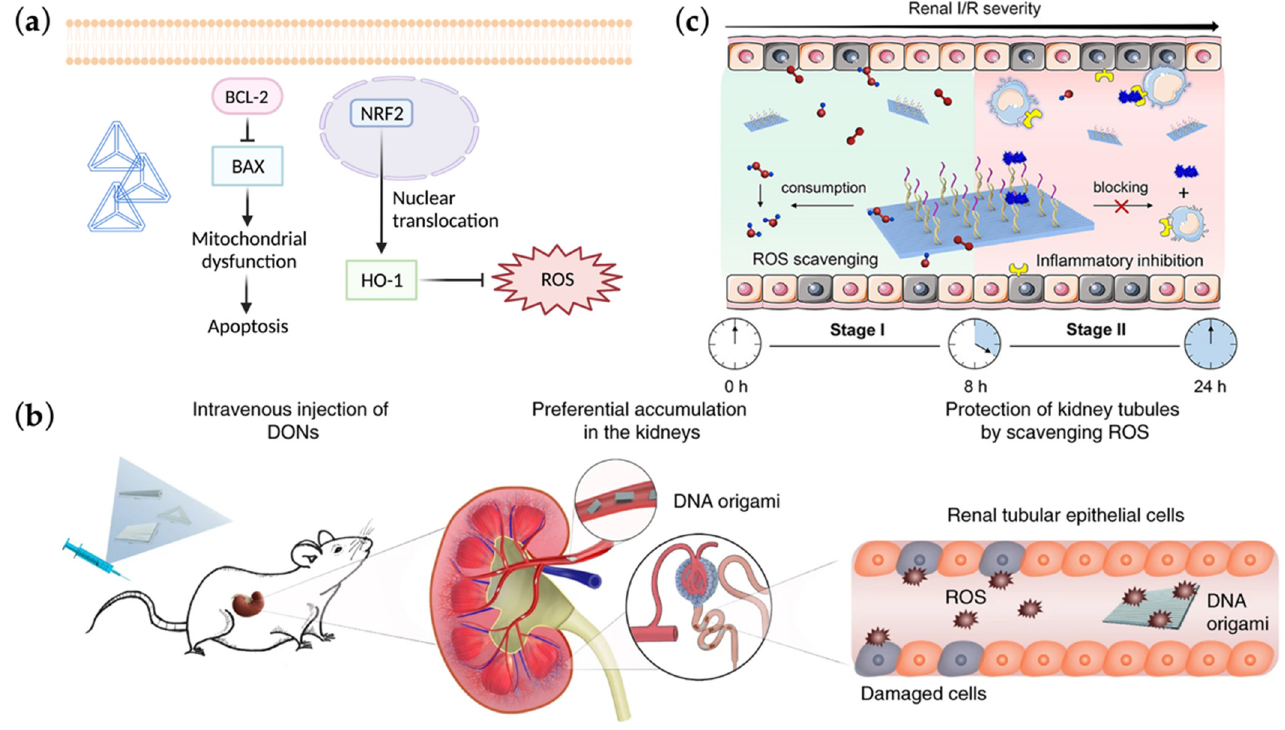
Figure 4. Mechanisms involved in AKI therapeutics targeting oxidative stress mediated by various nucleic acid nanotools. ( a ) Graphic display of how DNA tetrahedron nanostructure (DTN) functions as a potential AKI therapy through reducing oxidative stress and inhibiting apoptosis in renal tubular cells. Adapted with permission from [96] and created with BioRender.com (19 January 2022). Copyright © 2022, Elsevier; ( b ) Diagrammatic plot of how rectangular DNA origami nanostructures (Rec-DONs) accumulate in kidneys and neutralize reactive oxygen species (ROS) produced in AKI. Adapted with permission from [14]. Copyright © 2022, Springer Nature; ( c ) Schematic illustration of a sequential AKI therapy realized by nucleic acid nanodevices, in which Rec-DONs scavenge ROS during the first 8 h of ischemia-reperfusion (I/R) injury while the attached aptamers targeting complement component 5a are responsible for inflammatory inhibition after 8 h of I/R AKI. Adapted with permission from [103]. Copyright © 2022, American Chemical Society.